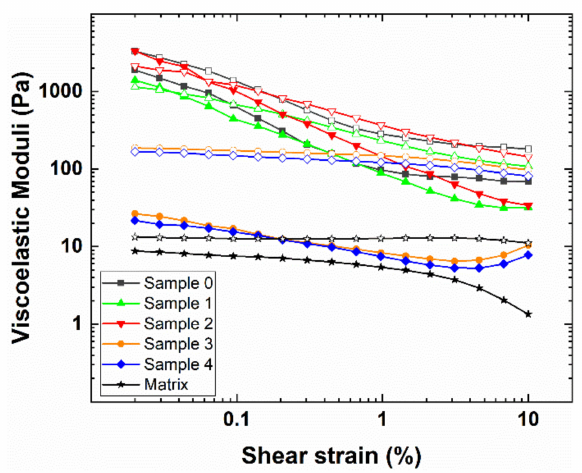
Figure 1. Dependence of the storage (filled symbols) and loss (empty symbols) moduli of Table 2. Dependence of the complex modulus of the tested samples upon the applied strain. The rheological response of the pure matrix is reported in the figure inset for